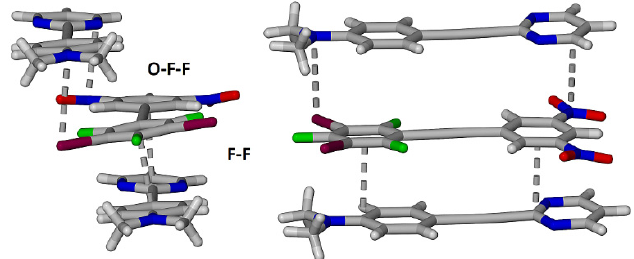
Figure 12. Two views of adjacent alternately corrugated halogen bonded ribbons in the cocrystal